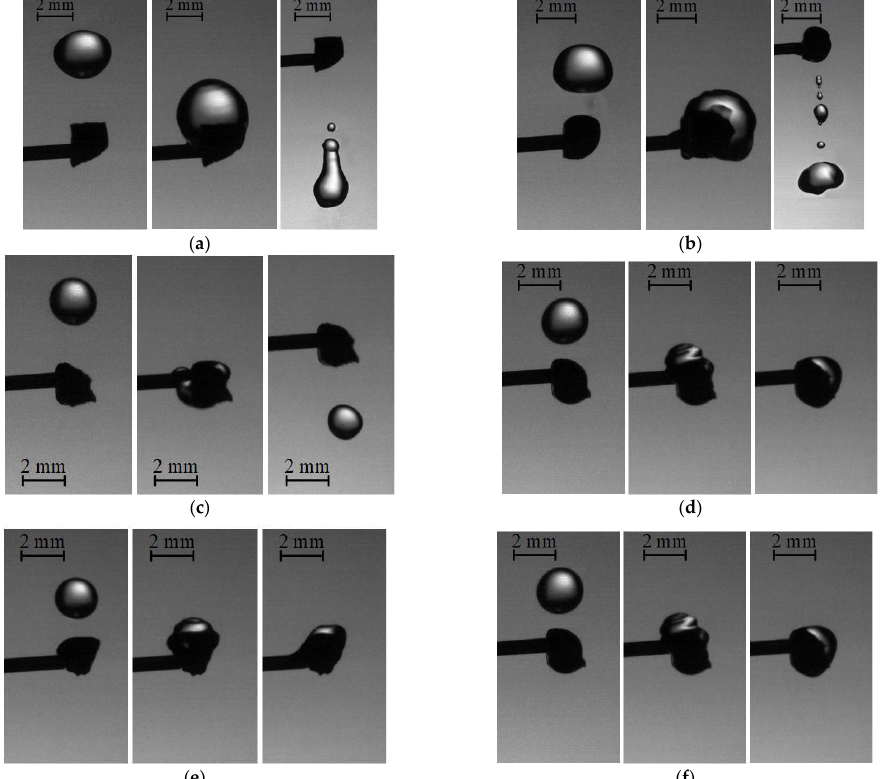
Figure 8. Images of collisions of distilled water droplets with carbonaceous particles of anthracite at varying droplet sizes: ( a , c , e ) — dry particles; ( b , d , f ) — particles containing water on the surface; ( a , b ) — R d = 1.45 mm; ( c , d ) — R d = 1.3 mm; ( e , f ) — R d = 1.1 mm. at varying droplet sizes: ( a , c , e )—dry particles; ( b , d , f )—particles containing water on the surface; ( a , b )— R d = 1.45 mm; ( c , d )— R d = 1.3 mm; ( e , f )— R d = 1.1